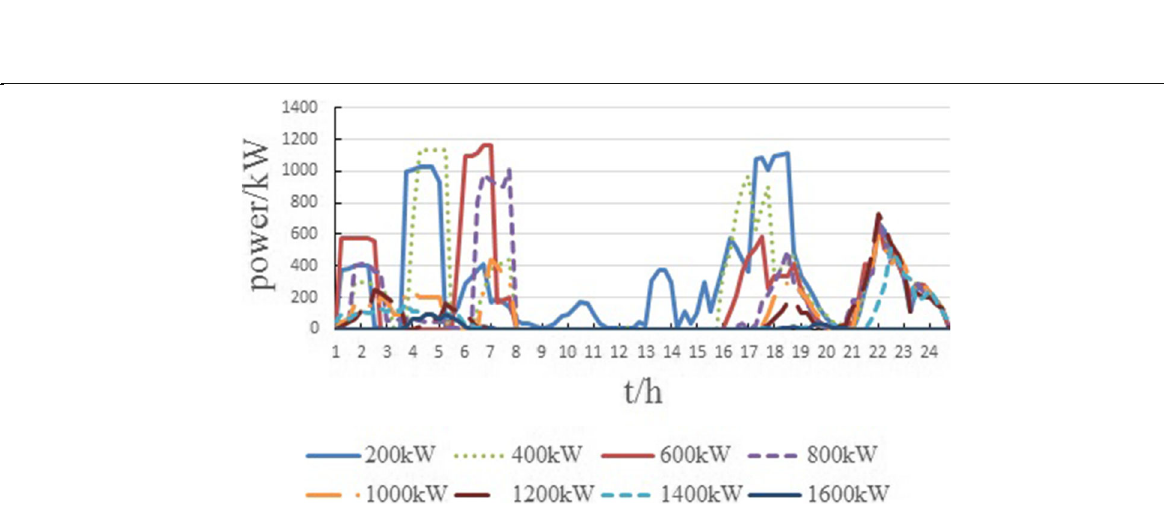
Fig. 15 System charging power curves with different PV capacities (PV bundling requirement = 80%)